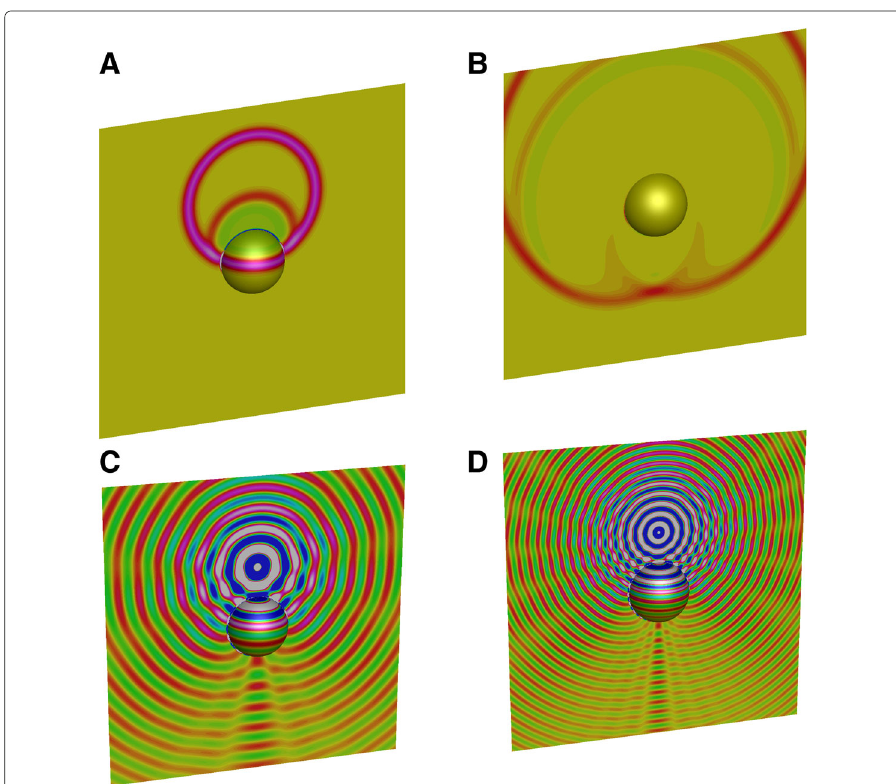
Fig. 5 Illustration of a time domain solution ( a and b ) and its converted frequency domain solution ( c and d ), scattering of a point source at point ( 0,0,1 ) by a sphere of radius a = 0.5 centered at ( 0,0,0 ) . Shown are the solutions at frequency ω(cid:4) t = π/ 8 and π/ 4, computed with c (cid:4) t / a = 1 / 24